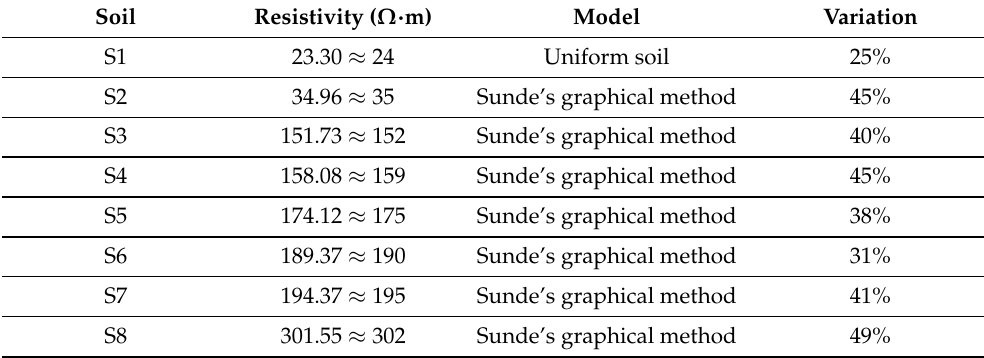
Table 2. Modelled resistivity of each